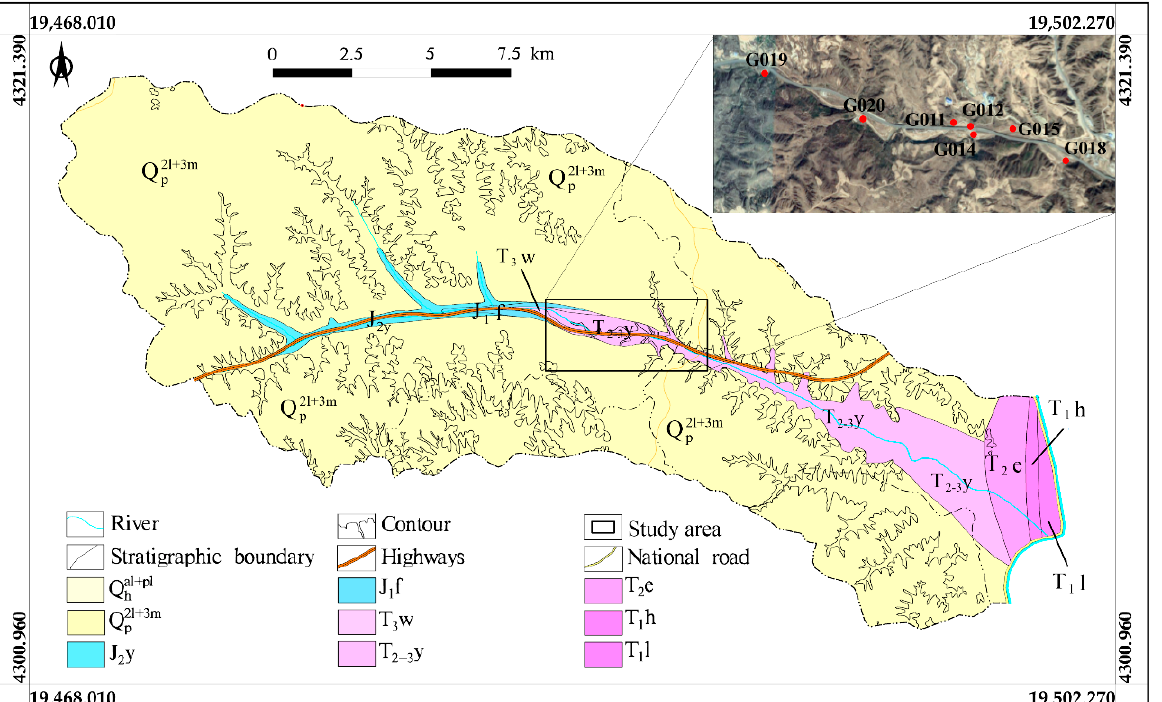
Figure 1. Regional geological map of Tianjiazhai East Ditch, Fugu County. The geographical location of the study area belongs to the 19th projection band of the Gaussian projection six-degree band, and the coordinates used in the figure are the Gaussian projection six-degree band coordinate sys- tem.